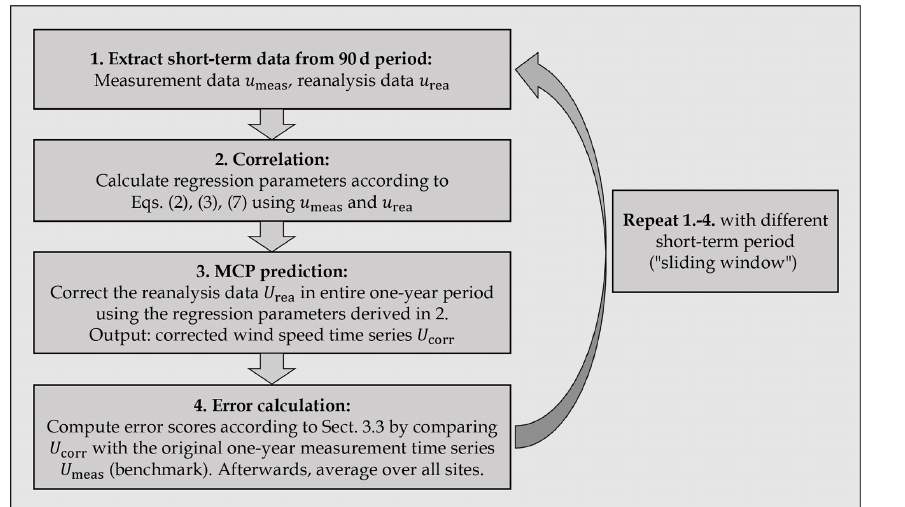
Figure 1. Illustration of the general procedure used in this study regarding the MCP predictions. After extracting the short-term data of measured ( u meas ) and reanalysis ( u rea ) data, a correlation function of these two wind speed time series is determined. This relationship is used to correct the reanalysis data in the entire 1-year period U rea . Finally, the obtained corrected data U corr is compared to the actually measured values (benchmark) U meas in order to estimate the accuracy. This procedure is done with all one hundred twenty-two 90d periods, all sites, and all reanalysis data sets